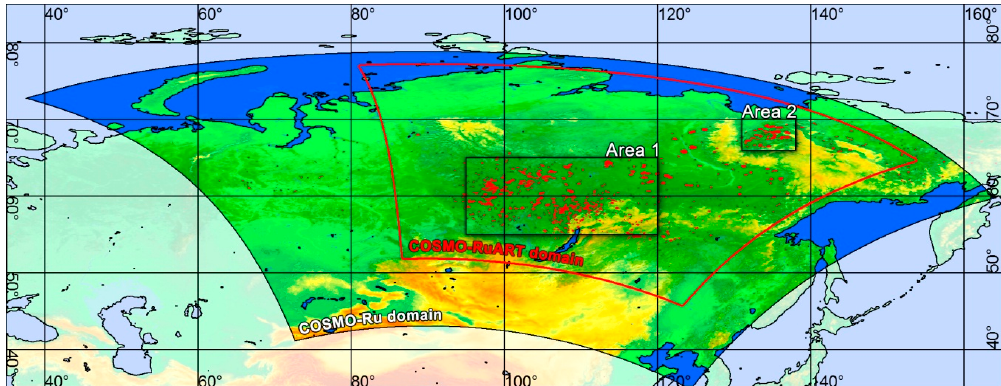
Figure 1. Geographical locations of the COSMO-Ru (COnsortium for Small-scale MOdeling; Ru—Russia) and COSMO-RuART (ART—Aerosols and Reactive Trace gases) modeling domains (contoured by black and red lines, respectively), as well as Study Area 1 and Area 2 (contoured by blue line) selected to analyze the possible effects of forest fires on weather conditions. Red spots are locations of forest fires within the modeling domains for selected period of 1–14 August 2019. The background color depicts surface elevation.